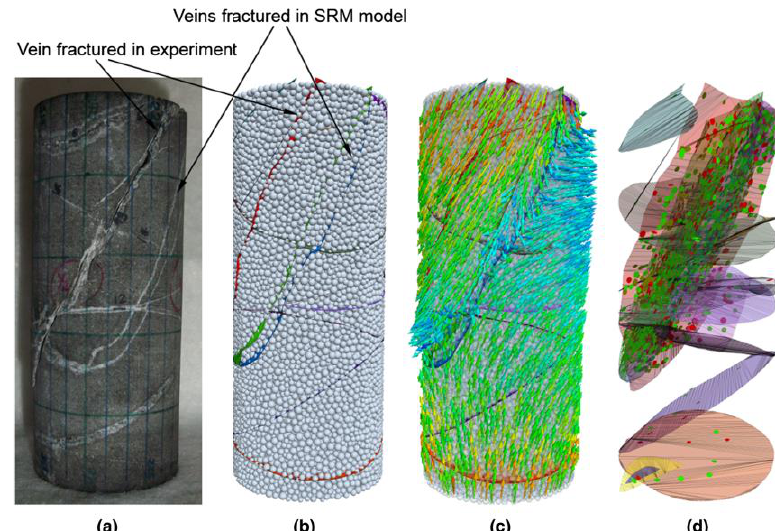
Figure 10. Damage patterns of the consolidated specimens.